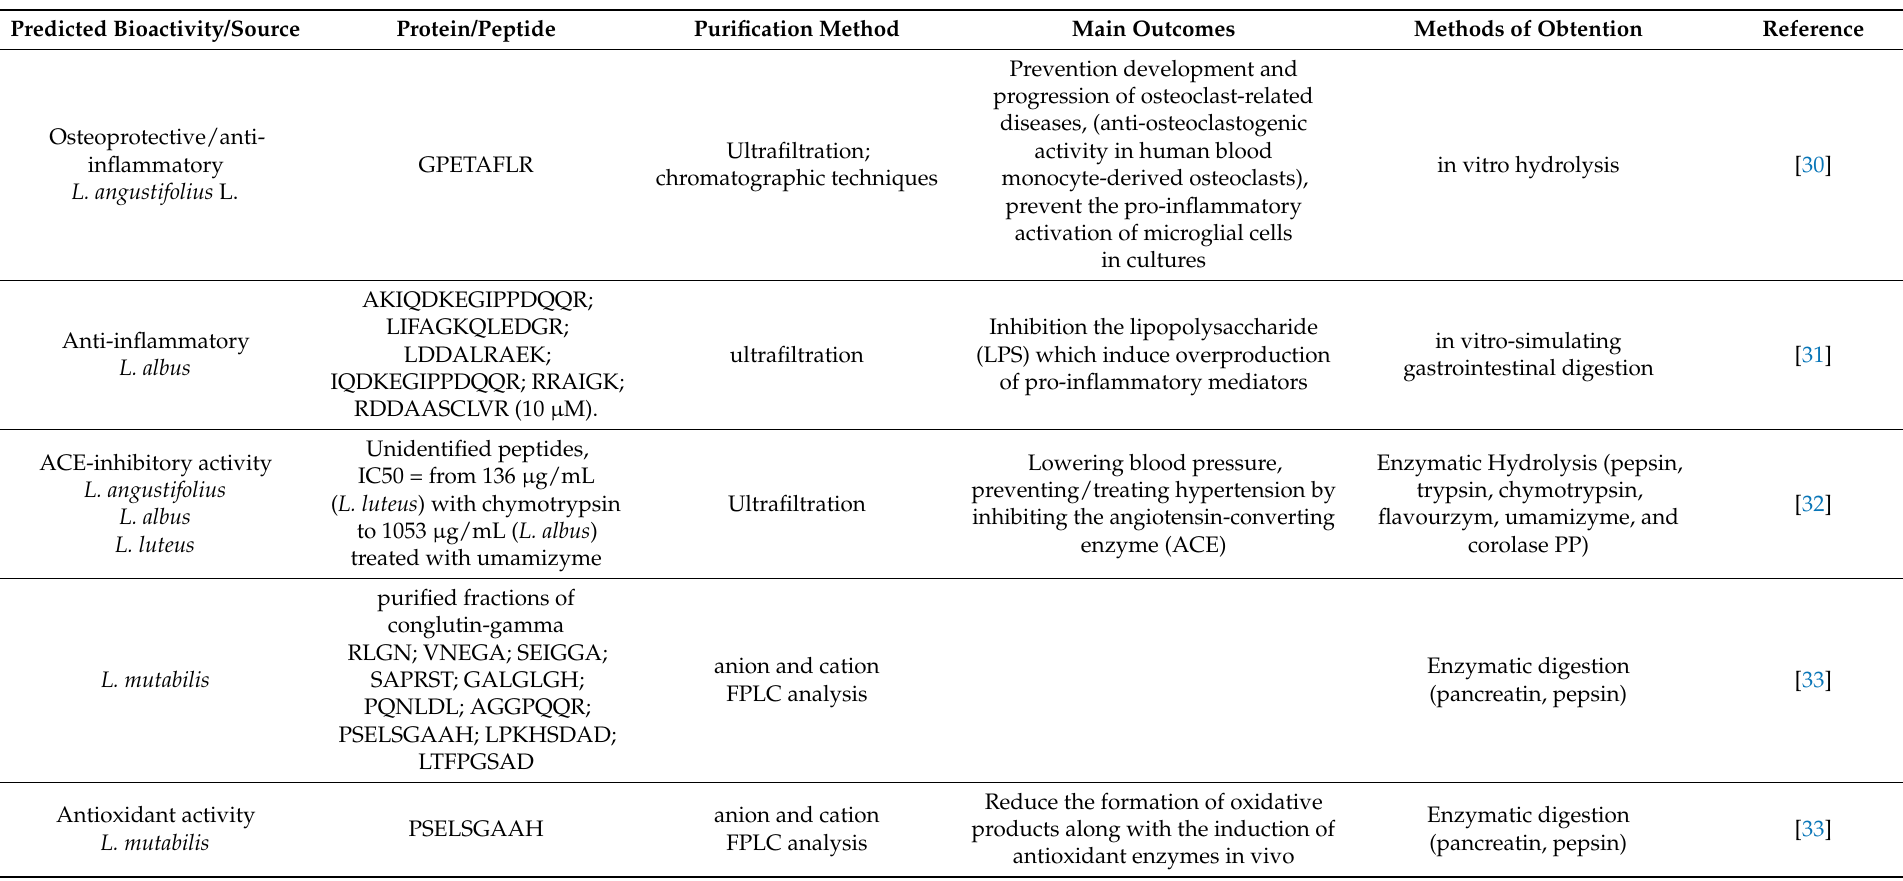
Table 2. Peptide sequences obtained from Lupin spp. and their predicted biological activities in purified